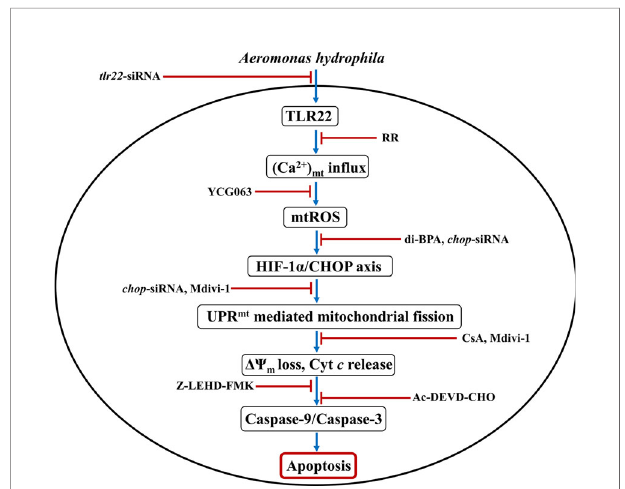
FIGURE 6 | Overview ofthestudy. TLR22-inducedCa 2+ in fl ux intomitochondria triggersmtROSgenerationleadingtodownstream activationofHIF-1 a /CHOPaxis. ActivatedCHOPinstigatesUPR mt -mediatedfragmentationofthemitochondrial networkleadingtomitochondrialdysfunctionwhichactivates caspase-9/caspase-3 axis-mediatedapoptosisof A.hydrophila